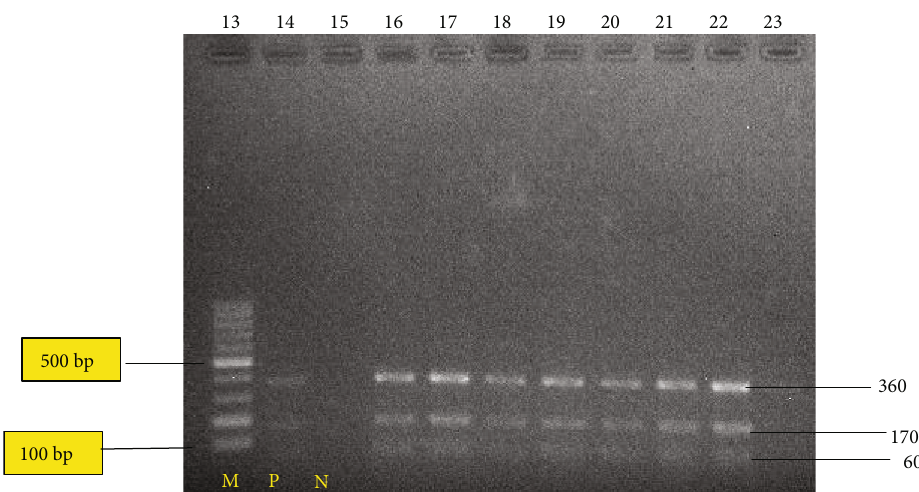
Figure 3: RFLP pattern of PCR product of liver fl uke collected from bovine in Shah Alam, Banting, Taiping, and Ipoh abattoirs after digestion with RsaI enzyme. Lane 21: 100 bp ladder molecular; lane 22 positive control; lane 23 is the negative control; lanes 24 to 31: denoted to those of F. gigantica . The PCR product digested were run on 2% agarose gel at 100v for 60 minutes.